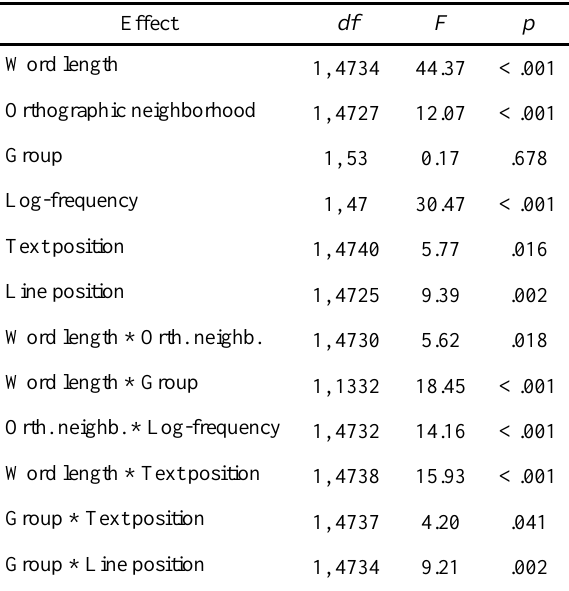
Table 3. Gaze duration: ANOVA summary.